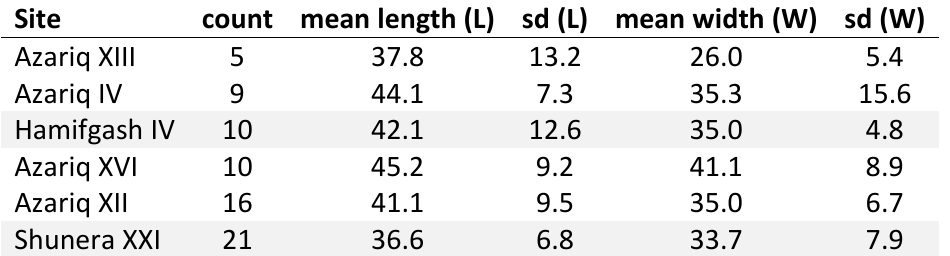
Table 5. Metrics for the cores of the sites studied (in mm). Abbreviations: sd - standard deviation.